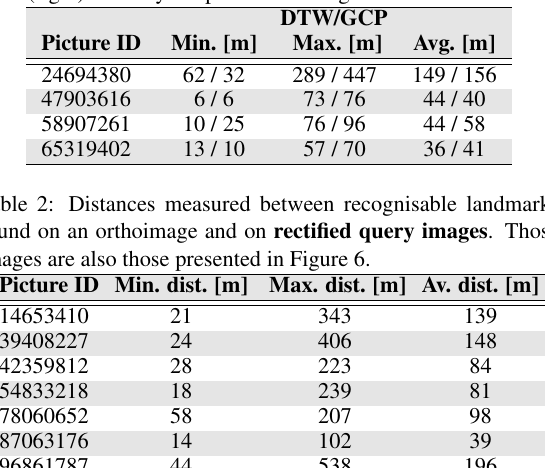
Table 1: Distances measured between recognizable landmarks found both in an orthoimage and in rectified reference GPS im- ages. Reference images were oriented either with DTW (left) or GCP (right) and they are presented in Figure 6.